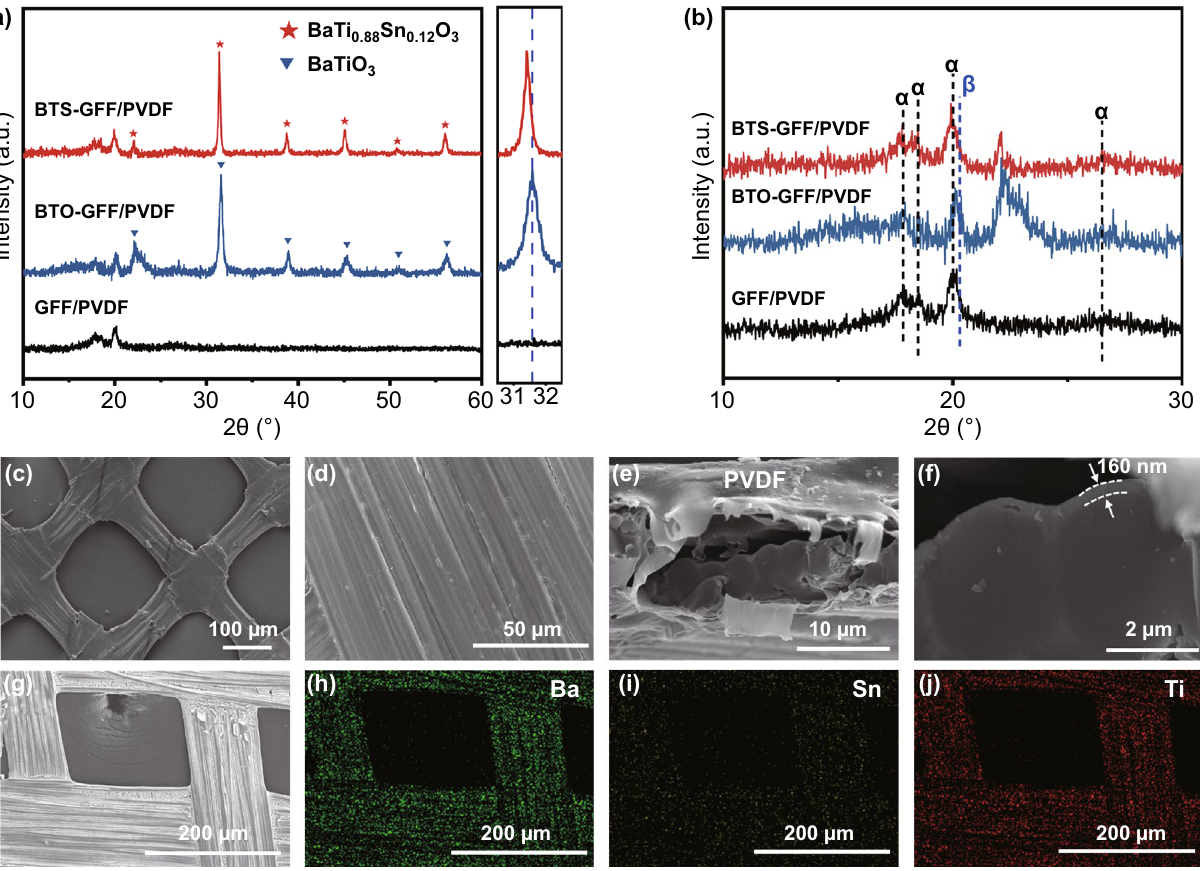
Fig. 1 a, b XRD patterns of BTS-GFF/PVDF, BTO-GFF/PVDF and GFF/PVDF composite films. c–f SEM images of BTS-GFF/PVDF com- posite film. g–j The element mapping result of BTS-GFF